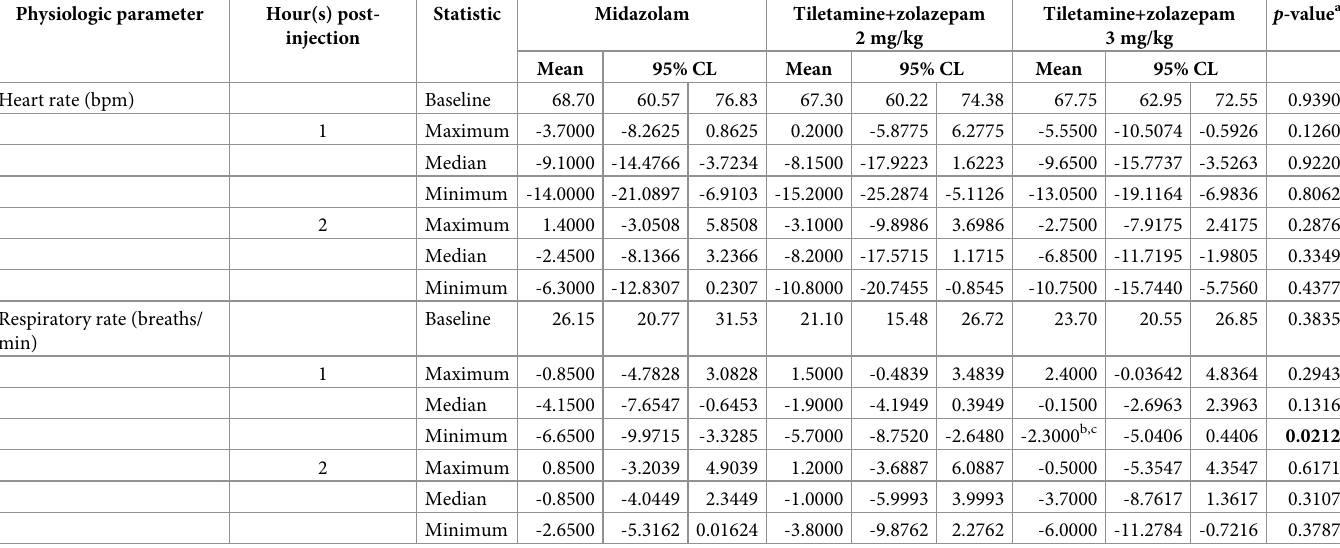
Table 3. Impact of midazolam or tiletamine+zolazepam on mean heart and respiratory rates in ball pythons. Physiologic